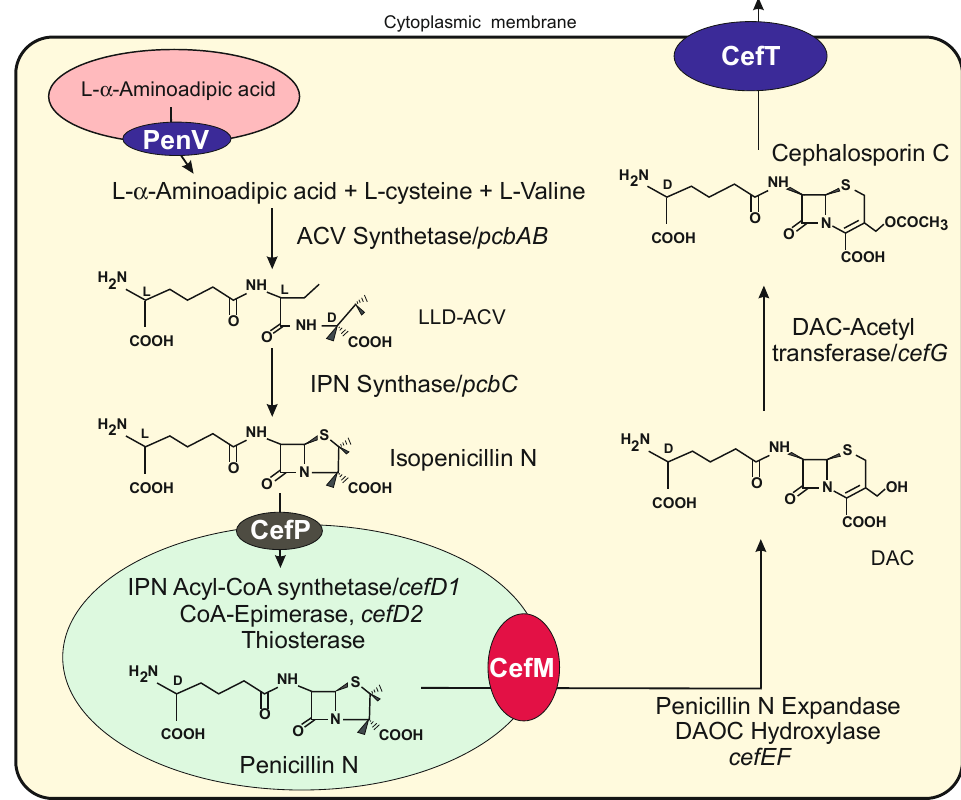
Figure 2. Biosynthetic pathway of cephalosporin C in A. chrysogenum, indicating the subcellular location of the different enzymes and intermediates. A vacuole is shown in pink color, and a putative PenV-like transporter in the vacuole membrane is proposed in a black ellipse. A peroxisome is shown in green color, and the tranporters CefP and CefM are indicated in black and red ellipses, respectively. The CefM protein may also be located in multivesicular structures (see text). The transporter CefT is located in the cell membrane.